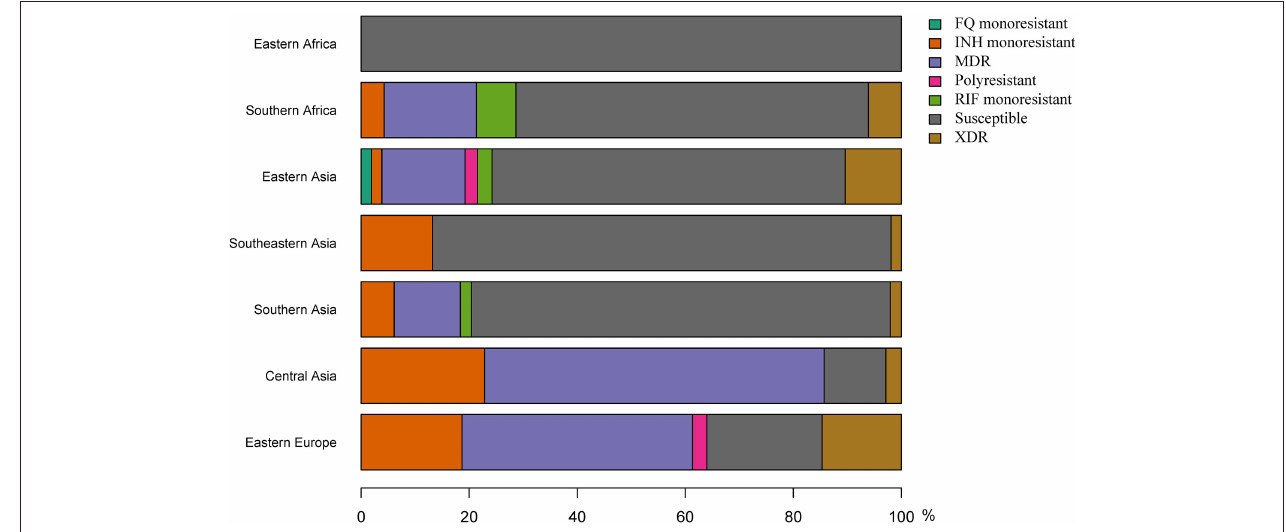
FIGURE 6 | Proportions of drug resistance profiles for L2 strains in seven geographical